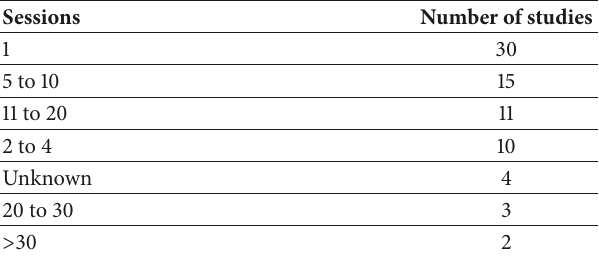
Table 9: Number of sessions in included studies.